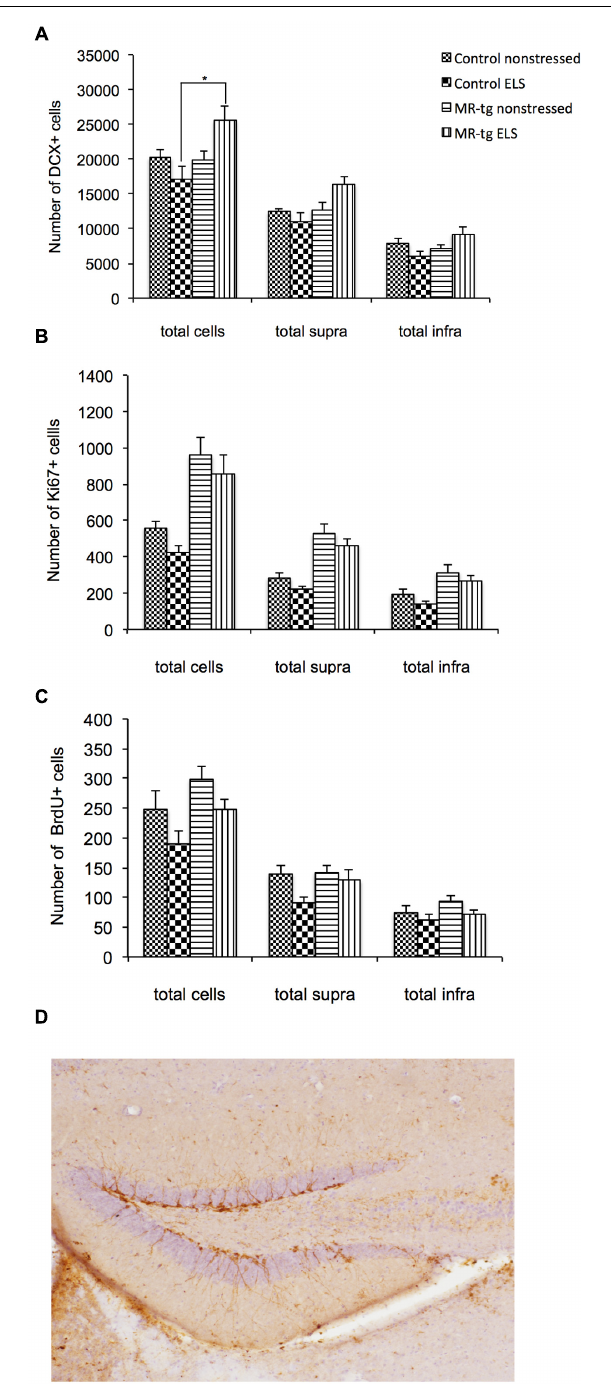
FIGURE 5 | Structural plasticity in MR-tg and control mice. Bar graphs represents the averaged results for: (A) DCX positive cells, (B) Ki67 positive cells and (C) BrdU positive cells. For all markers, we analyzed the total number of positive cells in the whole DG and along the suprapyramidal (supra) and infrapyramidal blade (infra). Data are expressed as mean ± SEM with p -values based on post hoc LSD. n = 6–10 animals per group. ∗ significant, p ≤ 0.0125. (D) Shows a representative image of DCX staining in the control